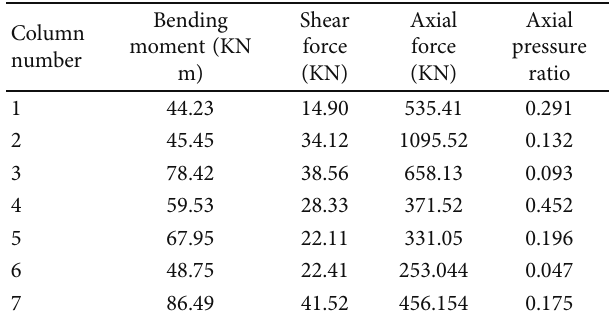
Table 3: Internal forces after column optimization.